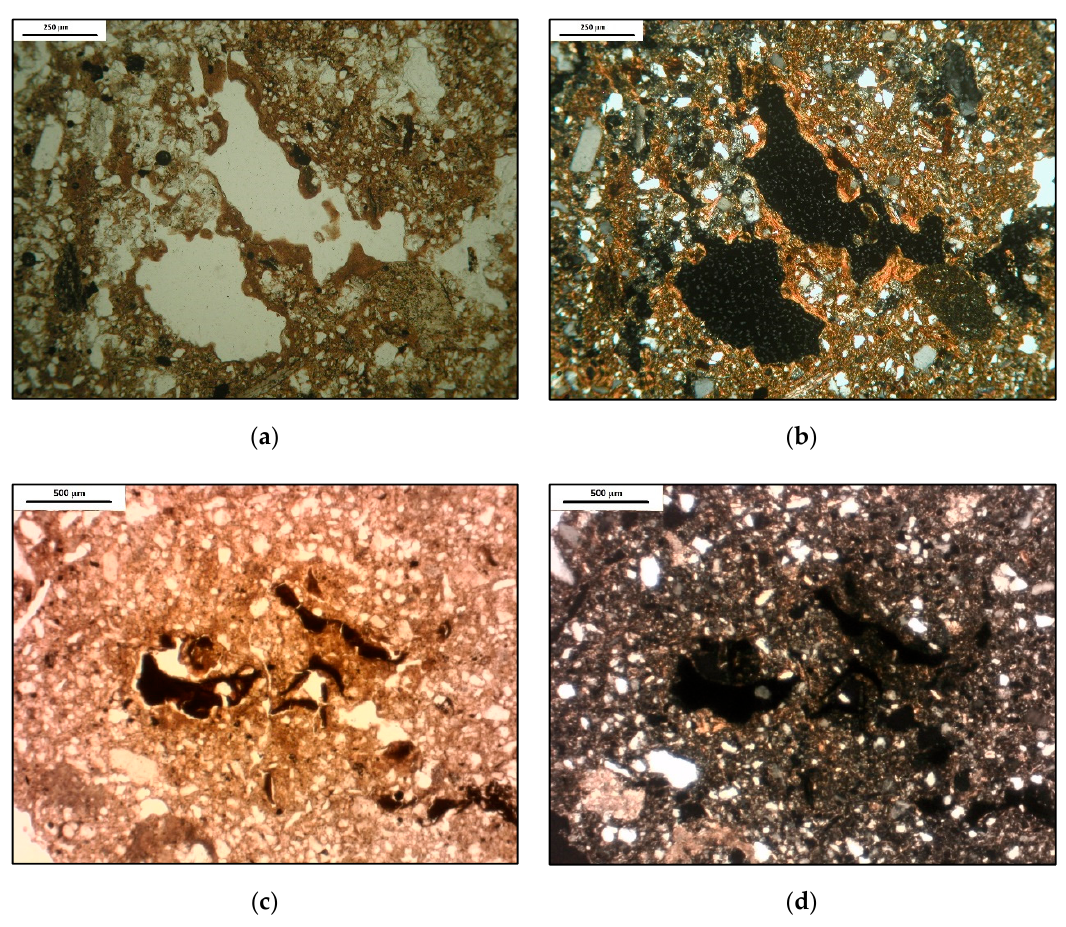
Figure 7. ( a , b ) Microphotograph of a previous loess deposit and of silty clay parallel laminated coatings (PPL in a , XPL in b ). ( c , d ) Microphotograph of a loess deposit, incorporated in the micromass, and limpid, parallel laminated dark clay coatings. Their color indicates the presence of iron and manganese. These features (loess deposit and clay coatings) indicate, respectively, an arid climate stage followed by a more humid